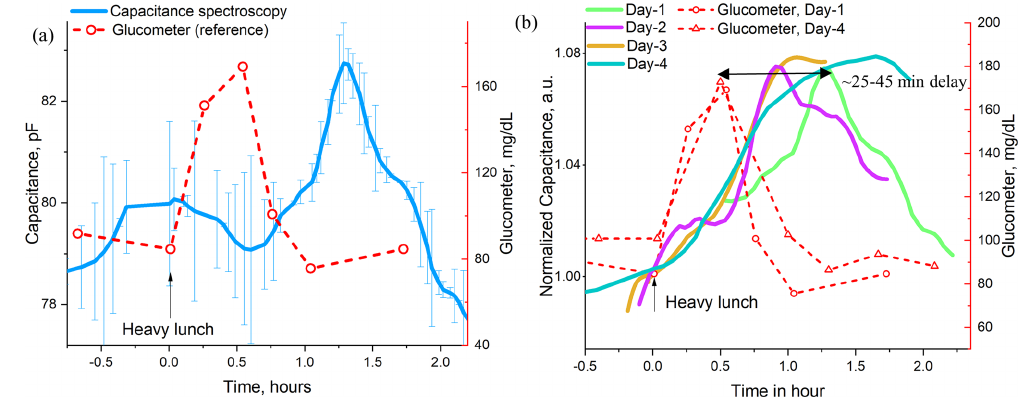
Figure 5. (a) Oral meal tolerance test (OMTT) for capacitance measurement with reference measurement from glucometer, (b) summary of the capacitance spectroscopy at different